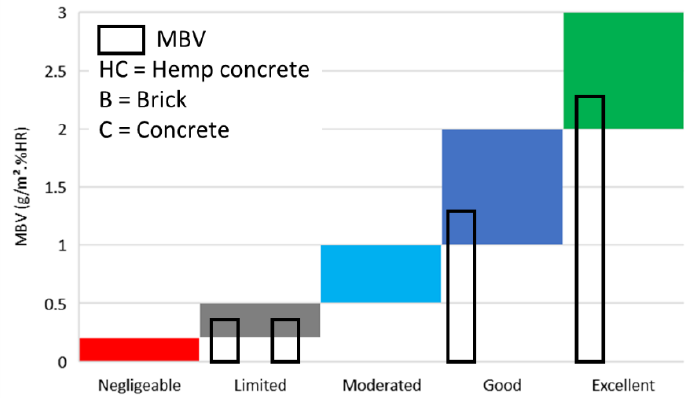
Figure 15. Comparison of cob MBV with other materials.